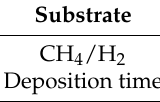
Table 1. Parameters of different processing conditions.